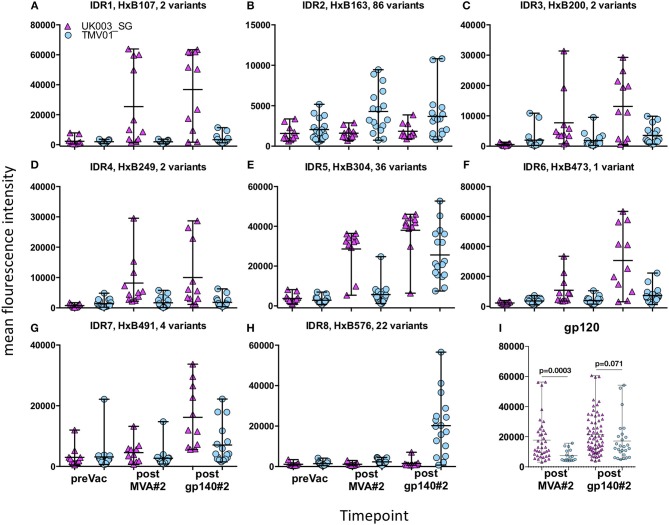
Comparison of IgG responses targeting selected frequently recognized regions in UK003SG or TMV01. Shown is for the eight selected immunodominant regions [IDR1-8 (A–H)] for each analyzed vaccinee the mean recognition MFI over all tested antigenic variants at baseline, after the second boost with MVA and after the second boost with CN54gp140/GLA. The first HxB aa position of the 15 mer peptide and number of tested variants are indicated for each antigenic region. The mean MFI of responses for each antigenic region recognized within gp120 by above 25% of vaccinees are shown in (I). The results of the statistical analyses by Mann-Whitey test comparing data from the two trials are indicated only for (I). Data points from UK003SG and TMV01 are shown in magenta and light blue, respectively. The statistical analyses for differences in mean recognition magnitude for (A–H) is provided in Table 1.